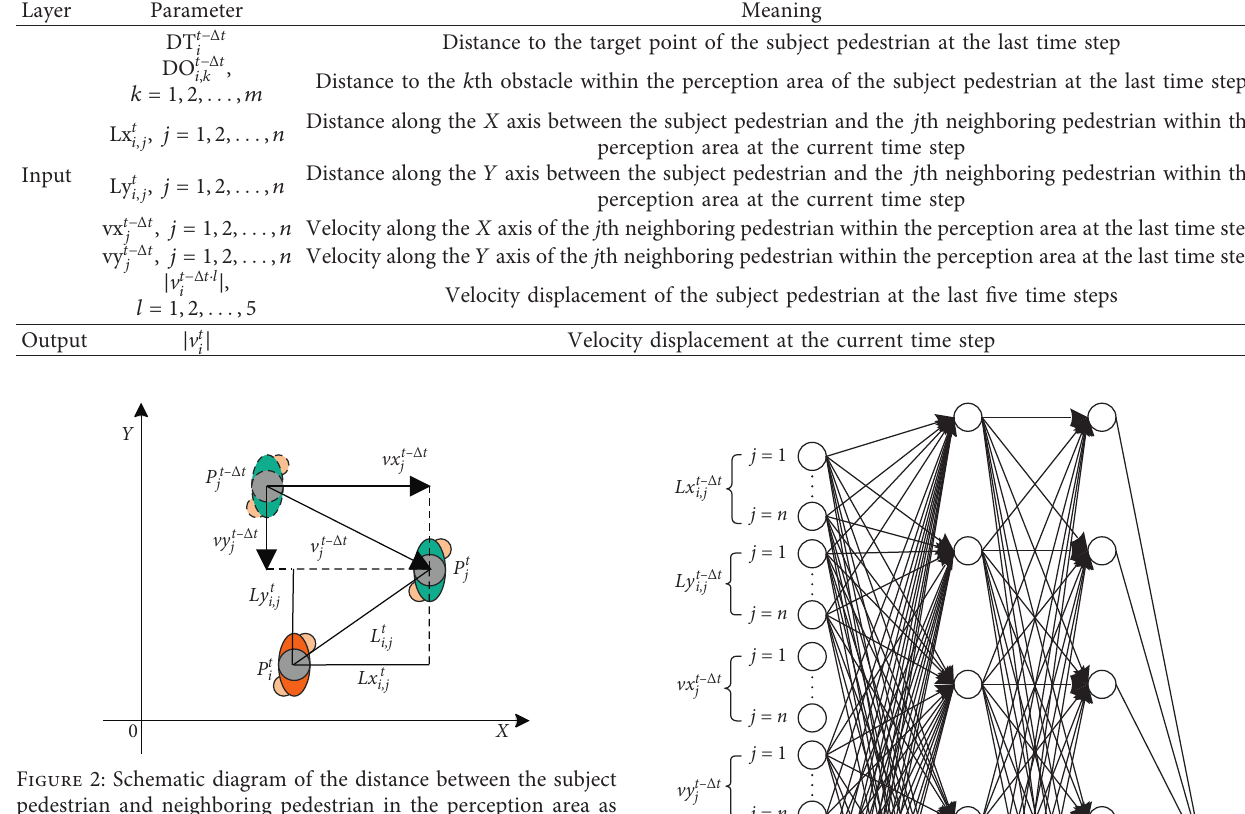
Table 1: Inputs and outputs of the VDSM.